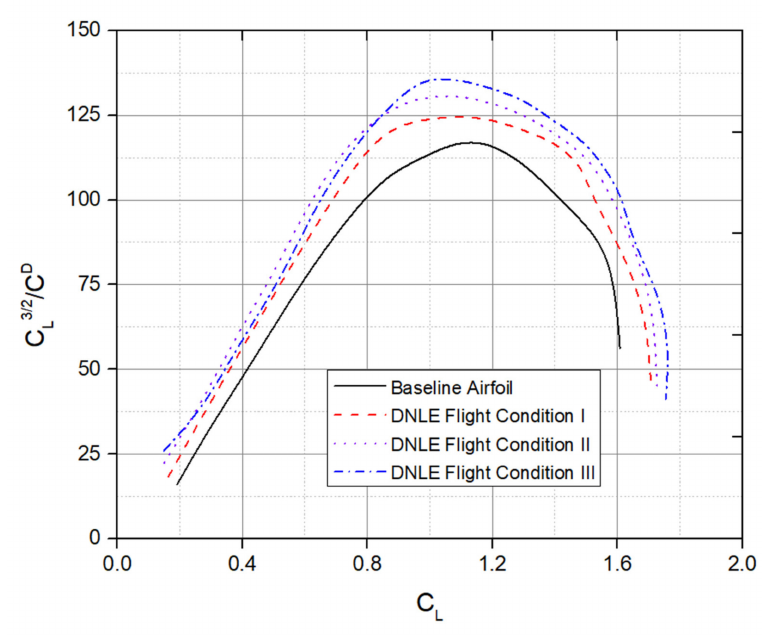
Figure 17. Comparison of the endurance for baseline and DNLE